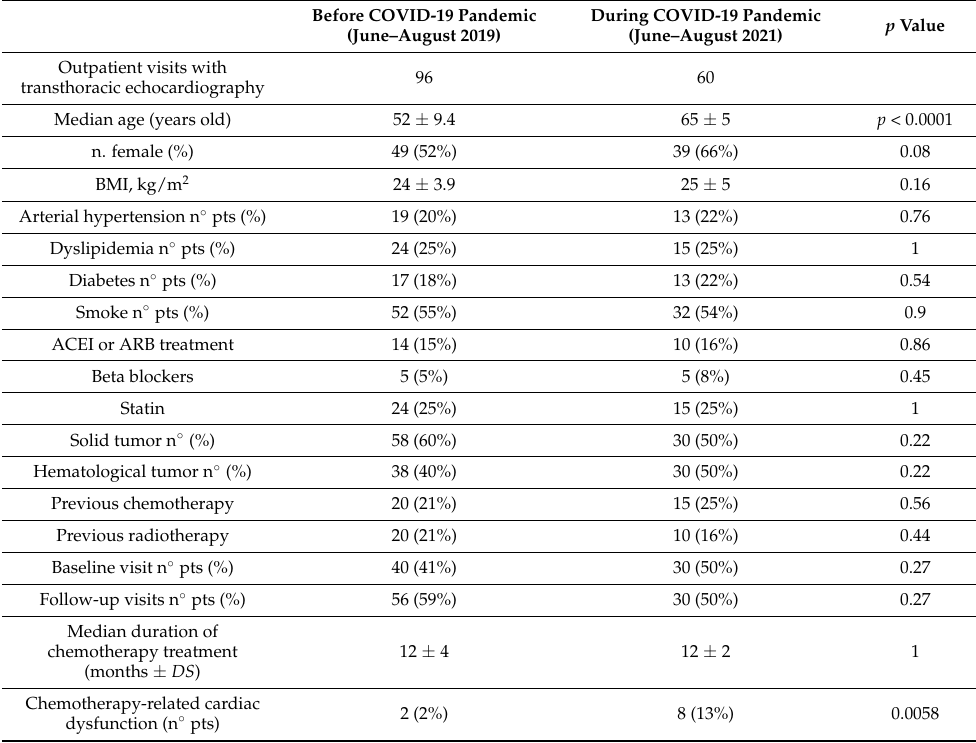
Table 1. Patients’